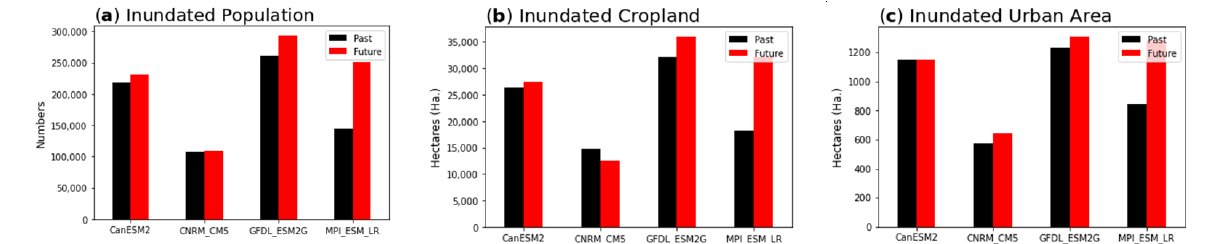
Figure 14. Socio-economic damage assessment.